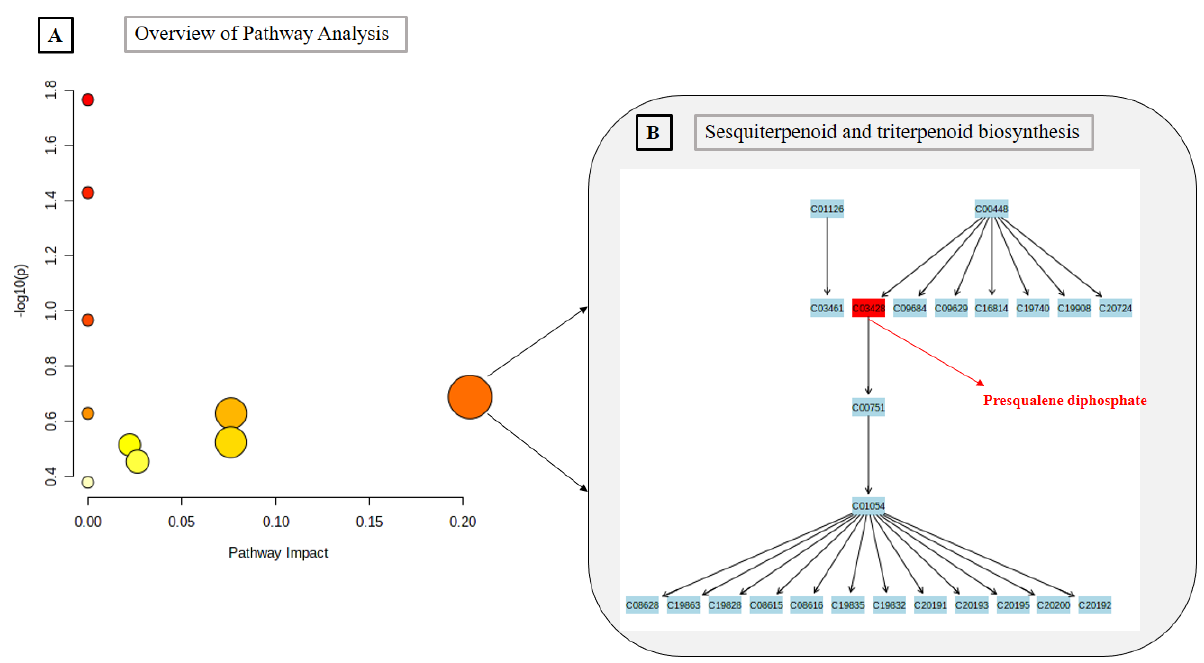
Figure 3. Pathway analysis ( A ) metabolome view, ( B ) pathway with higher impact.